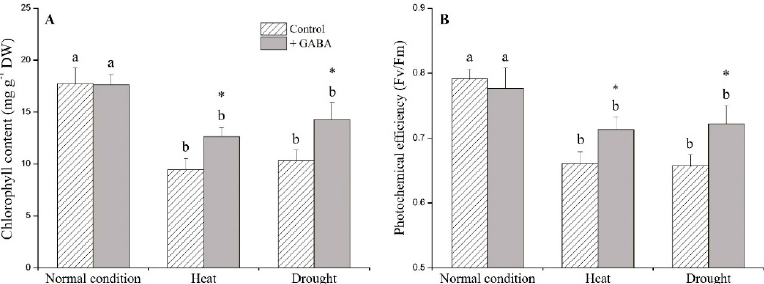
Figure 2. Effects of γ -aminobutyric acid (GABA) on ( A ) chlorophyll content (Chl) and ( B ) photochemical efficiency (Fv/Fm) in creeping bentgrass under normal, heat, and drought condition. Vertical bars indicate ± SE of mean ( n = 4). Different letters above columns indicate significant differences for one particular treatment (control or +GABA) under different conditions; asterisk “*” indicates significant difference between control and +GABA treatment under a given